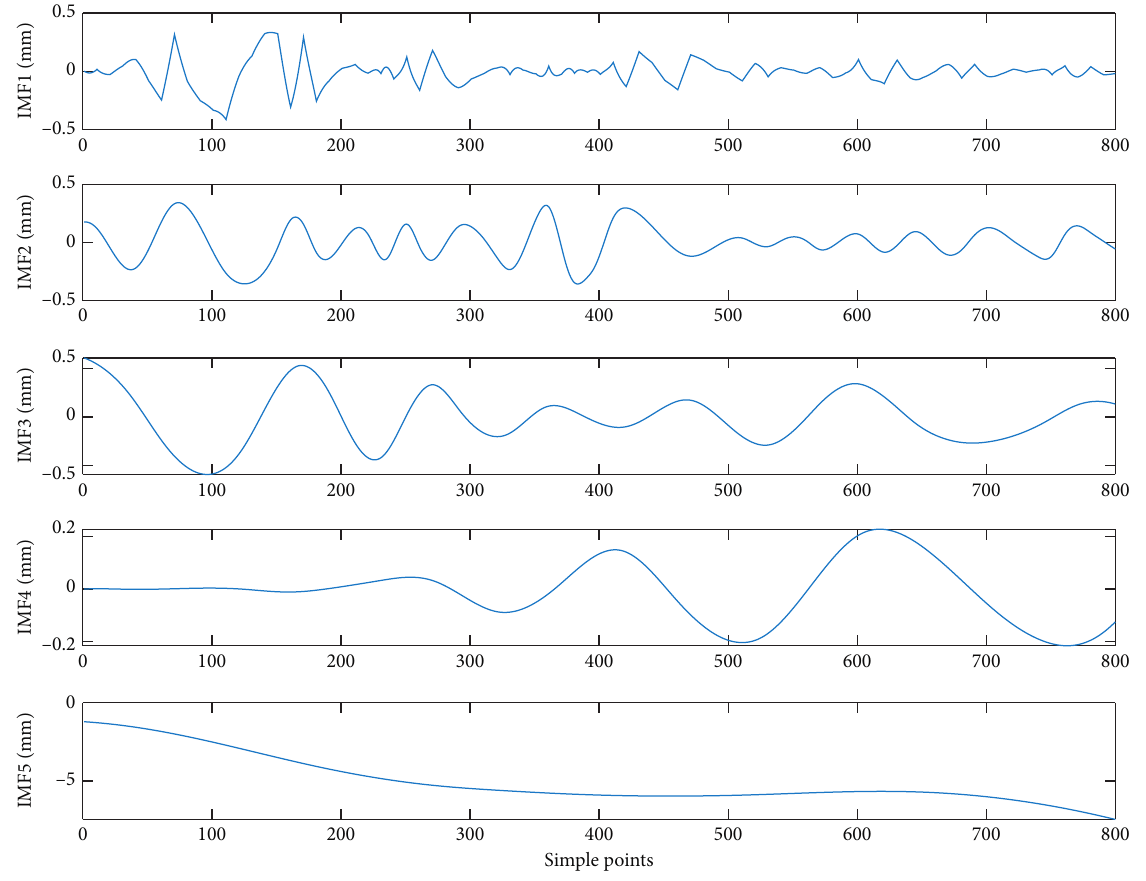
Figure 6: EMD decomposition result. Table 1: Signal energy characteristic value of each layer.